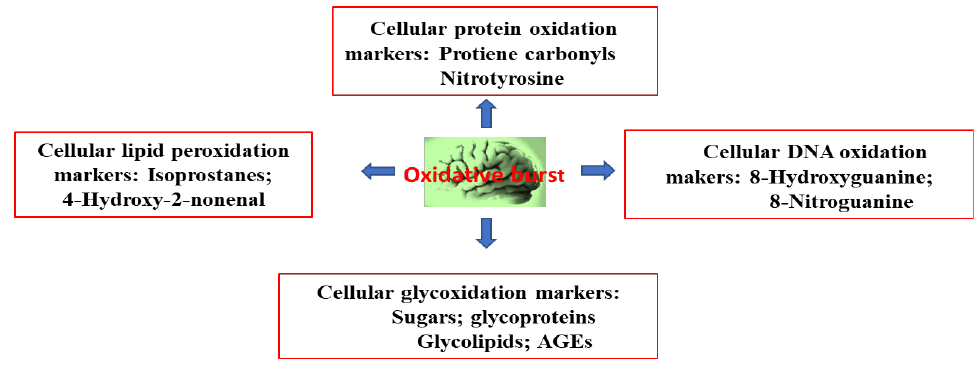
Figure 3. Oxidative burst produces different biomarkers in the brain.